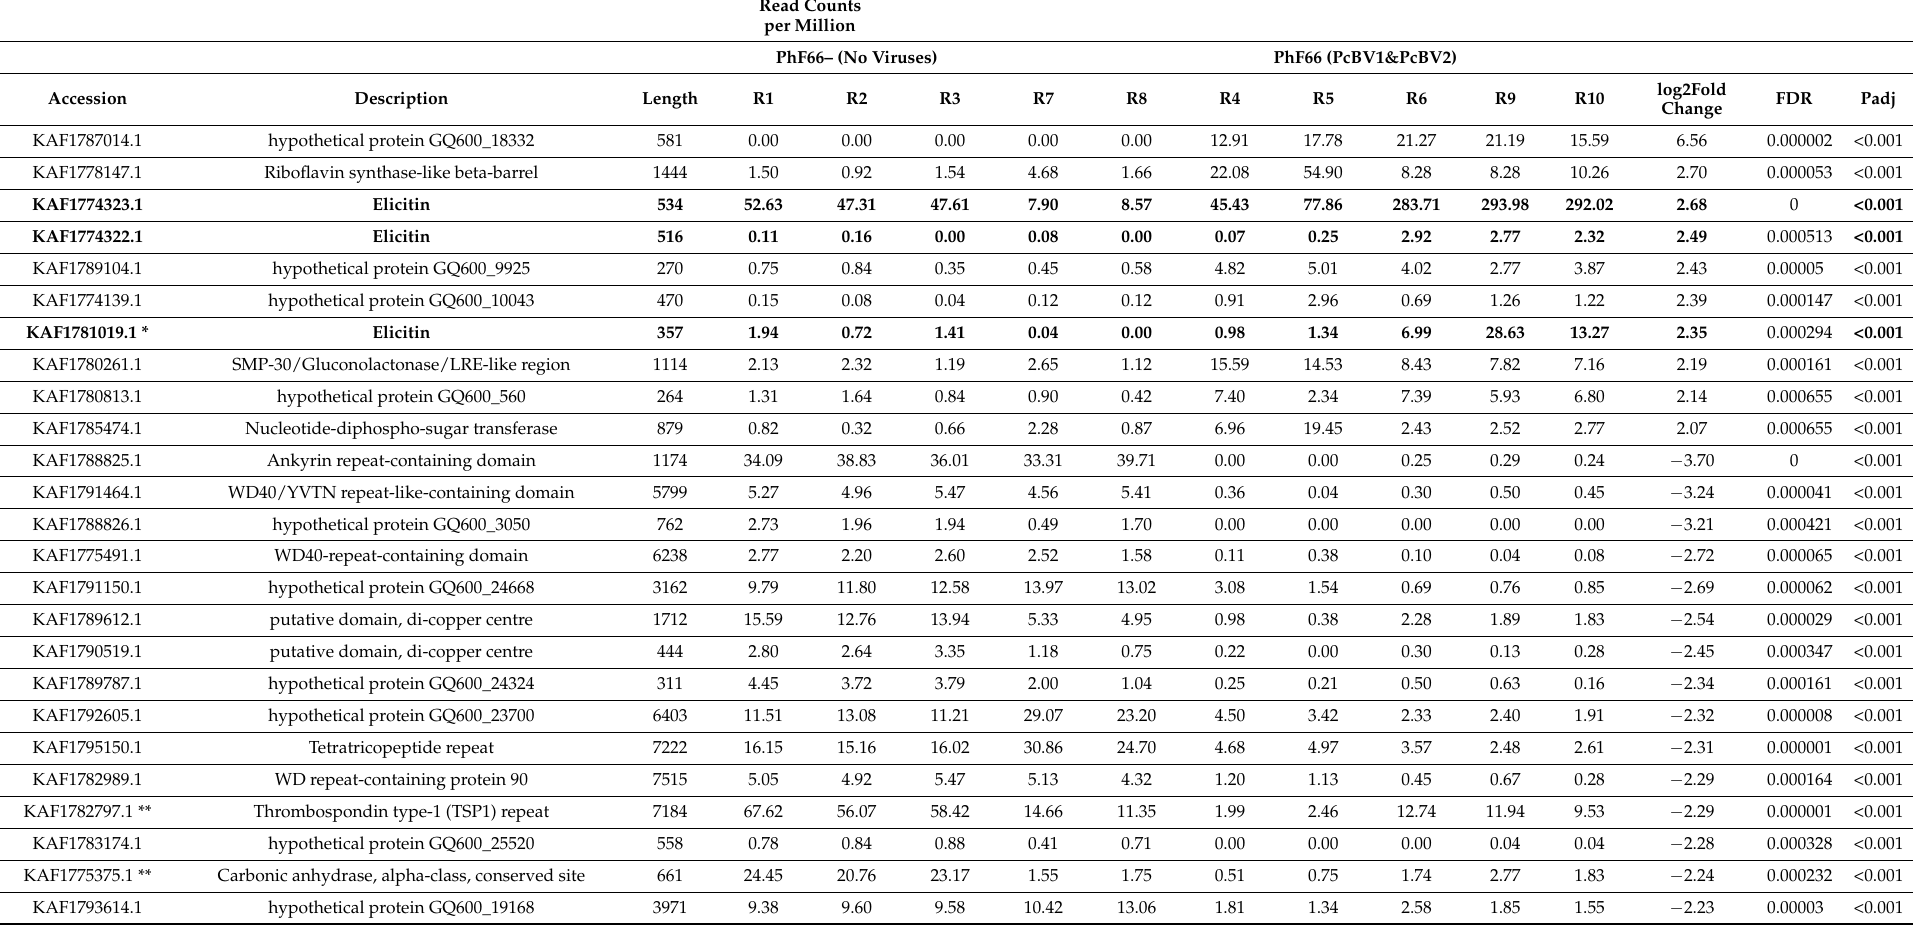
Table 3. Differentially expressed genes in the virus free P. cactorum isolate PhF66– and PhF66 containing two bunyaviruses with cutoff values >2 revealed by RNA-seq. * = corresponding proteins detected differentially abundant alsoin the shotgun proteomic analysis. ** = corresponding proteins detected, but not showing differences in abundance. Annotated elicitins are highlighted in